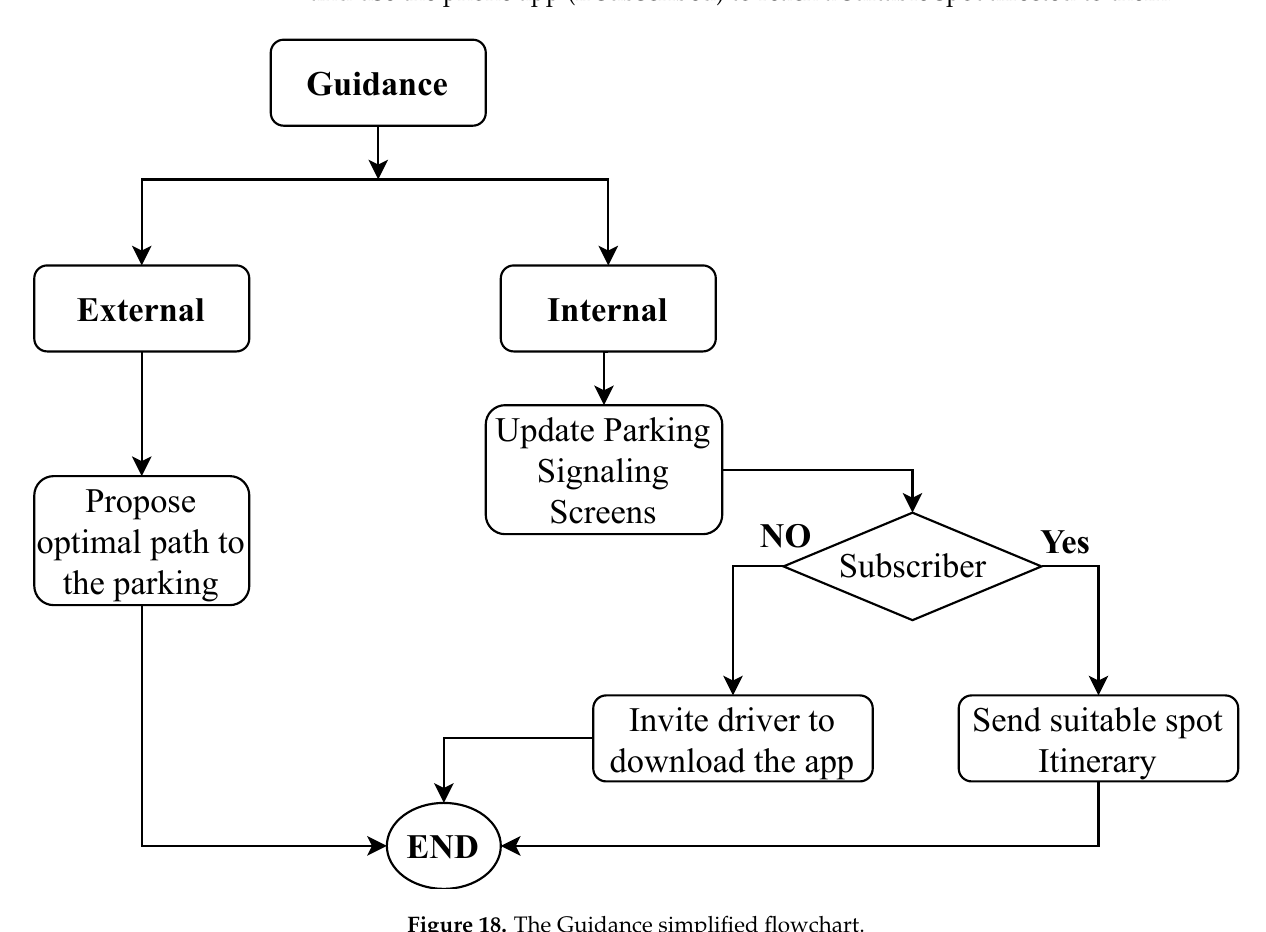
Figure 18. The Guidance simplified